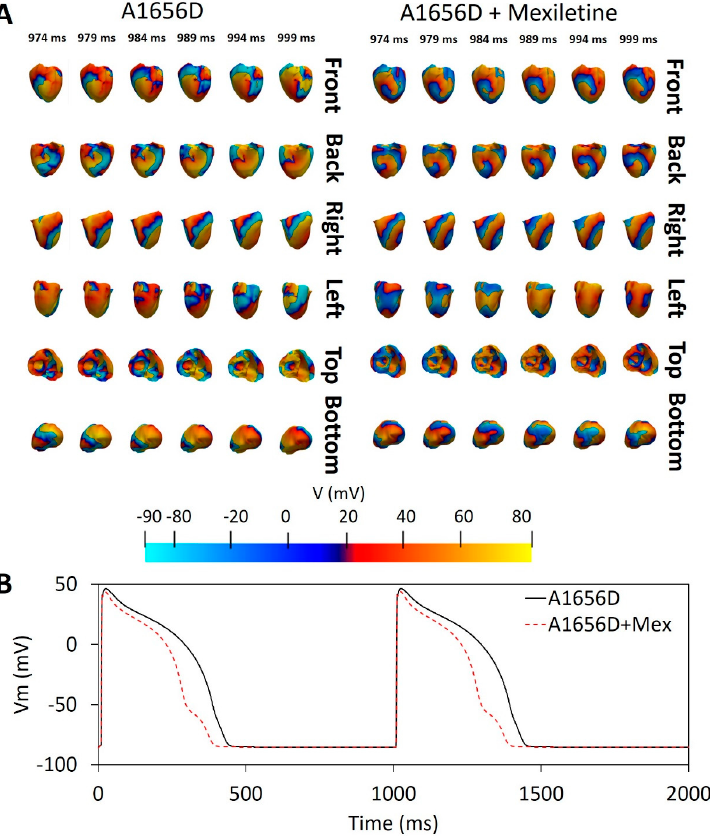
Figure 3. The outcomes of a 3D ventricular simulation. Panel ( A ) depicts the reentry dynamic from various angles, and panel ( B ) defines the action potential shape for A1656D and A1656D under mexiletine. The black star in Panel ( A ) shows the rotor. The cell type depicted in this illustration is the epicardia cell.